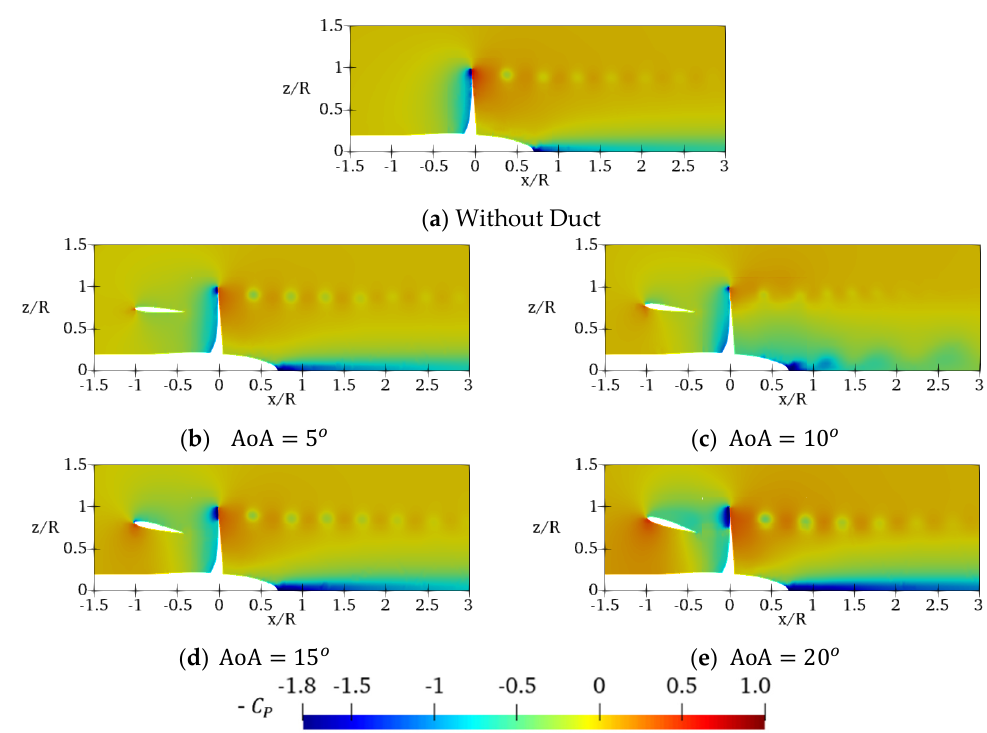
Figure 10. 𝐶 (cid:3017) contours on longitudinal plane for cases with 𝐷 (cid:3005) = 0.7𝐷 (cid:3017) . Figure 10. C P contours on longitudinal plane for cases with D D = 0.7 D P .